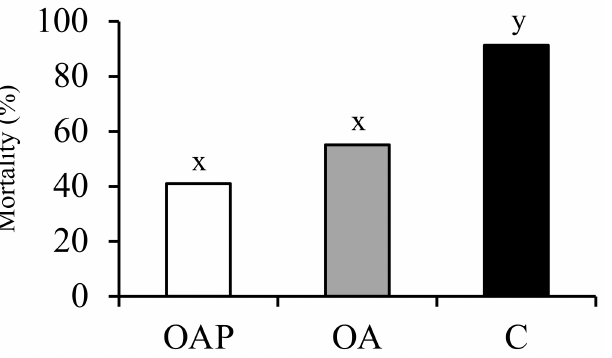
Figure 3. Mortality of porcine epidemic diarrhea-infected piglets. Bars represent mortality of piglets. Black bar, untreated control (C; n = 23). Gray bar, piglets receiving oral and abdominal rehydration therapy only (OA; n = 31). White bar, piglets receiving oral and abdominal rehydration therapy and oral probiotic supplementation (OAP; n = 49). Bars with different letters are significantly different ( p <